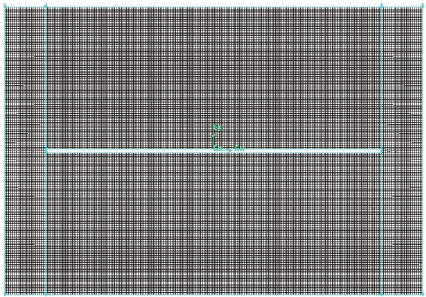
Figure 3: Grid structure corresponding to G3 (Table 3) for the